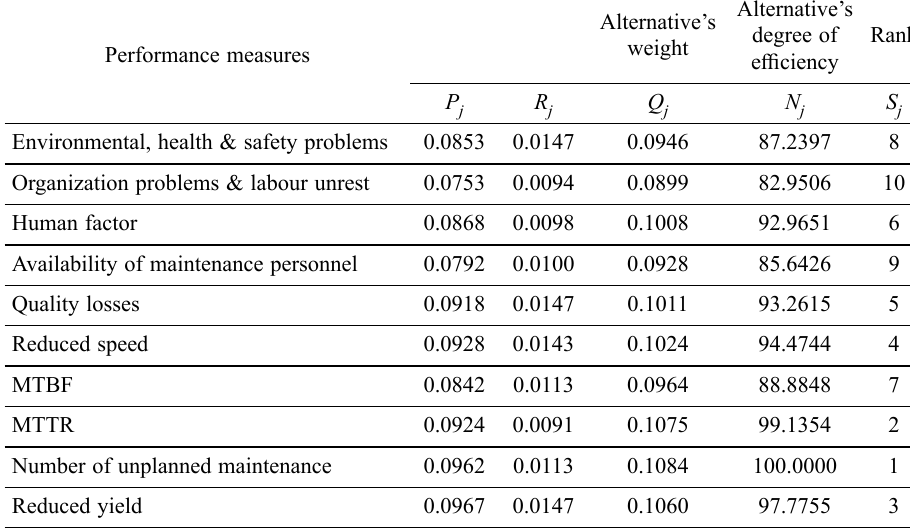
Table 6. Solution results